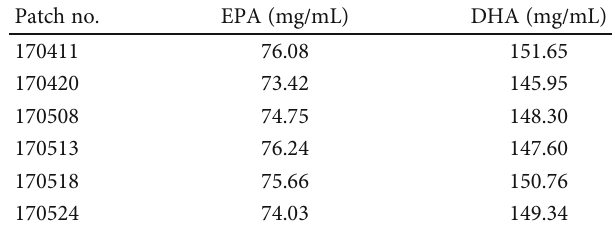
Table 3: EPA and DHA content in cod-liver